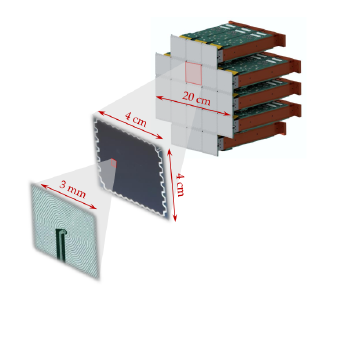
Figure 5. (Left) TRISTAN detector design for the second phase of the keV-sterile search. The full detector will consist of an array of 21 identical modules each consisting of 166 pixels. (Right) Expected 95% CL statistical sensitivity of the KATRIN experiment to keV-scale sterile neutrinos for di ff erent stages with the TRISTAN detector [19]. Phase-0 (dashed red line): integral measurement with a total statistics of 6 × 10 11 electrons. This could be achieved with a 7d measurement campaign at a reduced signal rate of 10 6 cps. This rate can be obtained with a reduced amount of tritium. Phase-1 (solid red line): di ff erential measurement with a total statistics of 10 16 electrons. This could be achieved with a 3 years measurement campaign and a signal rate of 10 8 cps. This signal rate can be obtained with a 100-fold reduced tritium column density (with respect to nominal KATRIN operation). The statistical limit (dashed black line) for a di ff erential measurement with a total statistics of 10 18 electrons is also reported. This limit represent the most optimistic scenario for which a measurement of 3 years with the full source strength of the KATRIN experiment can be achieved. The grey dashed area depicts the current laboratory-based limits